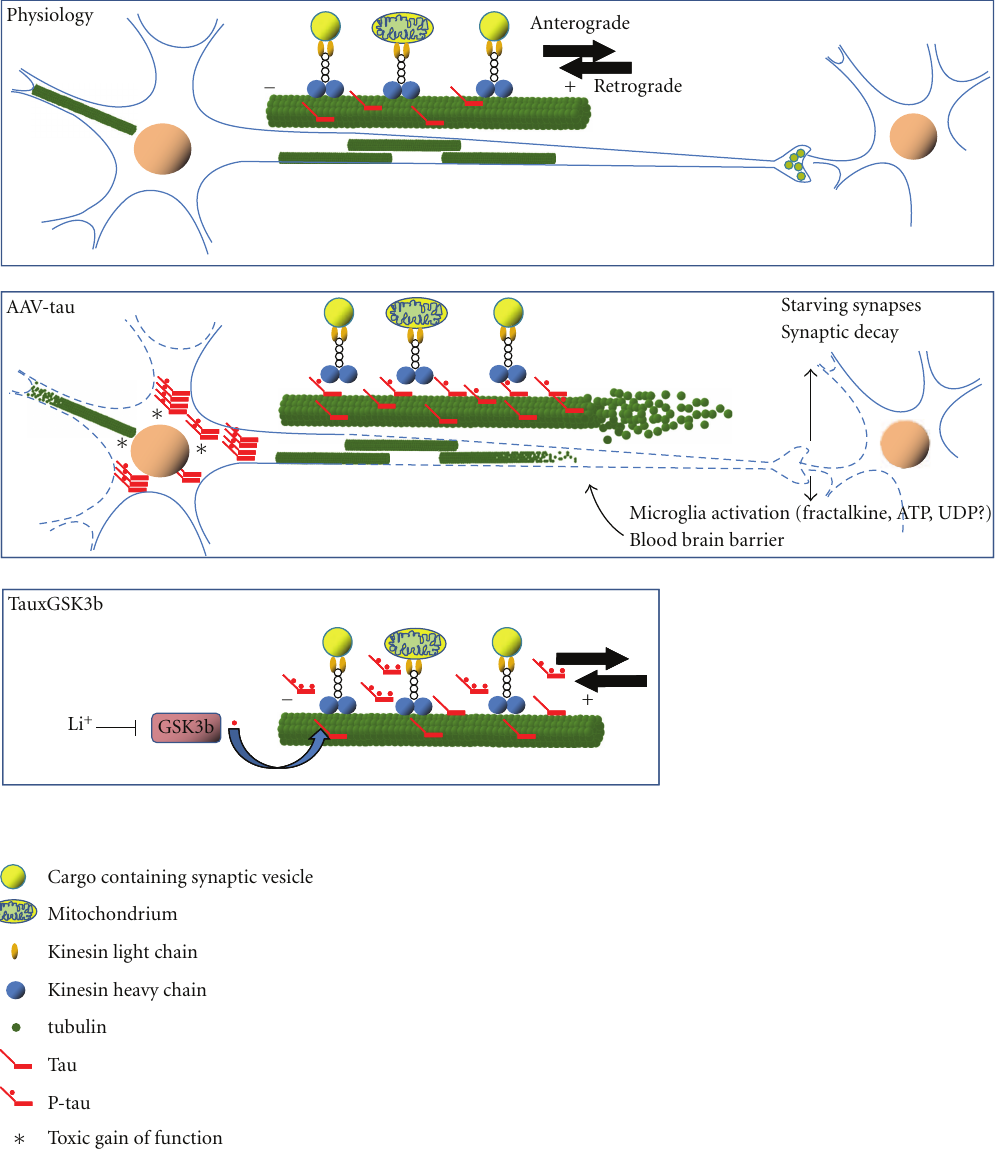
Figure 4: Model for Tau-mediated neurodegeneration. In normal conditions, protein Tau is regulated tightly at di ff erent levels: isoform expression, phosphorylation, microtubule binding, turnover, all needed to ensure normal transport along microtubules in axons and dendrites (upper panel). Increased expression of protein Tau, either genetically or pathologically in humans or experimentally in animal models will increase the amount of protein Tau bound to microtubules, thereby competing for and blocking the binding- sites needed for the motor proteins that carry out transport (middle panel). The resulting impairment in transport of any cargo, from synaptic vesicles and mitochondria to proteins, will impair any transport and energy-dependent processes at the synapses, which will extend and evolve into degenerating neuronal processes, and eventually lead to neuronal death. Defective synaptic transmission is then expected to be an early indication or symptom. Initially, small and loose aggregates or oligomers of protein Tau collect onto the microtubules, causing them to disintegrate or collapse. We also propose that the injured neuronal processes release proteins and factors, purposely or accidental that contribute to the activation of microglia and astroglia. The activated inflammatory cells secrete then factors that a ff ect not only neurons but also other cells that constitute the unit blood-brain-barrier, provoking higher permeability, which further negatively a ff ects neurons [11, 30]. Interesting is the connection to increased activity of GSK3, which rescued the axonopathy of Tau4R mice and the premature death of Tau.P301L mice by phosphorylating protein Tau and thereby detach it from the microtubuli to restore normal transport by motor proteins (lower panel) [26, 37]. Likewise, neither cell-death nor inflammation is provoked by AAV-Tau.255, devoid of the microtubule binding domain. The transgenic and viral models thereby underscore the microtubule binding of protein Tau as the common mechanism of action whereby protein Tau is causing neuronal demise and eventually